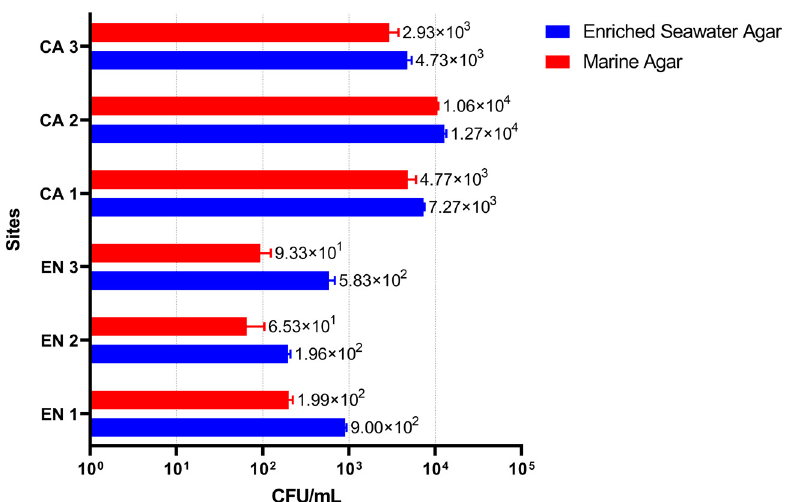
Figure 2. Microbial abundance of the cultured marine bacteria from the Black Sea. The number of colony-forming units (CFUs) per mL of water was calculated for the Cap Aurora (CA) and Eforie Nord (EN) sites as indicated in Methods. Error bars show the variations for three technical repli- cates.